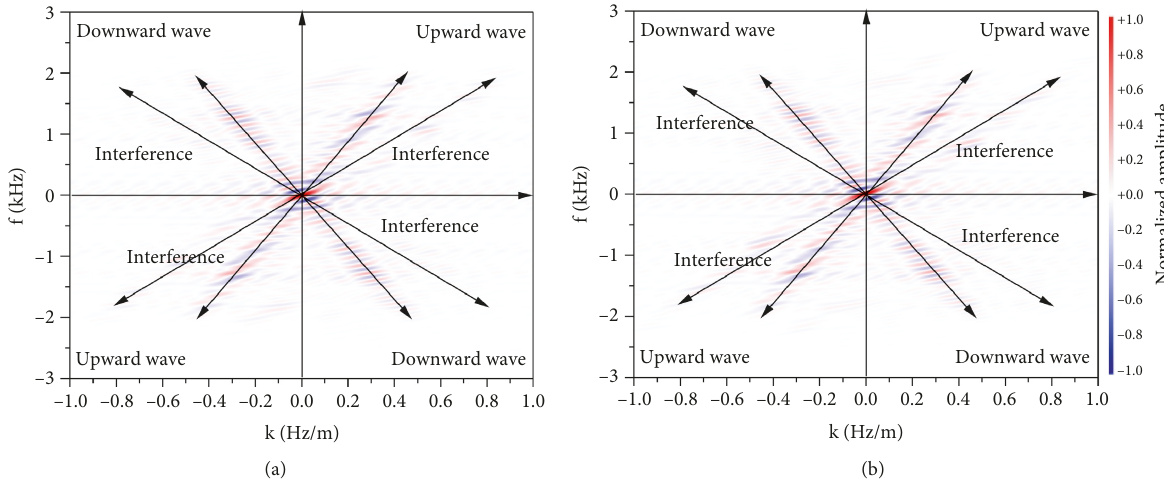
Figure 13: Results of frequency-wavenumber domain analysis ( y